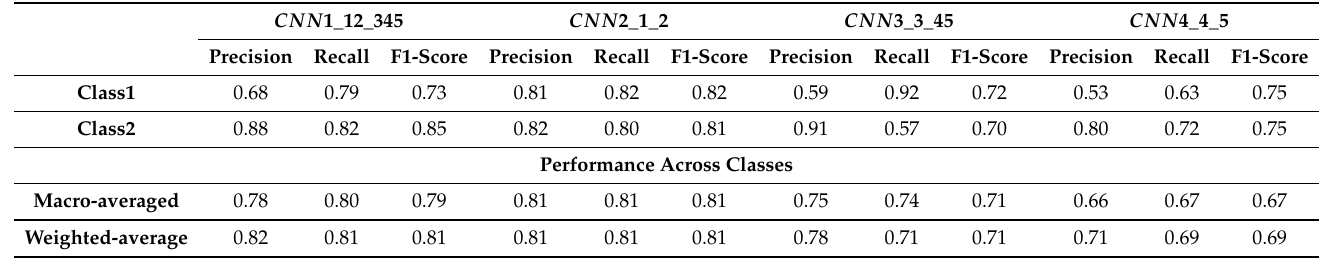
Table 6. Classification accuracy for the ResNet50 with the patch size 224 ×